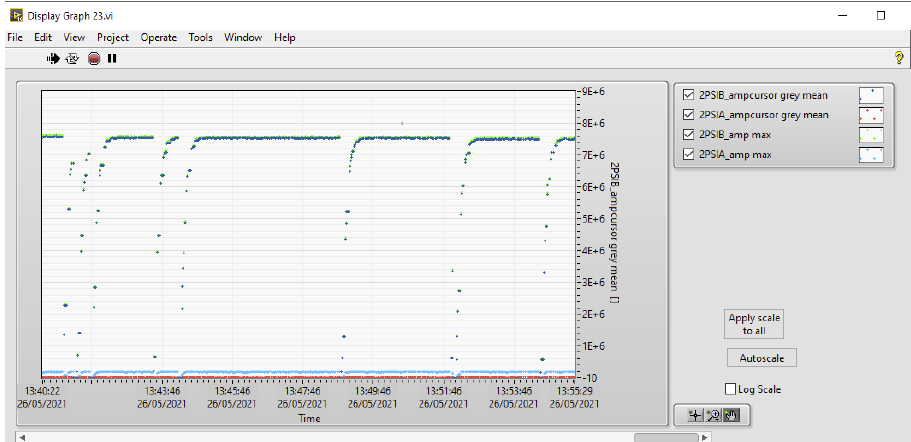
Figure 5. Example of how the PID control system increases the power until it equals that requested by the conditioning algorithm after the production of breakdowns. by the conditioning algorithm after the production of